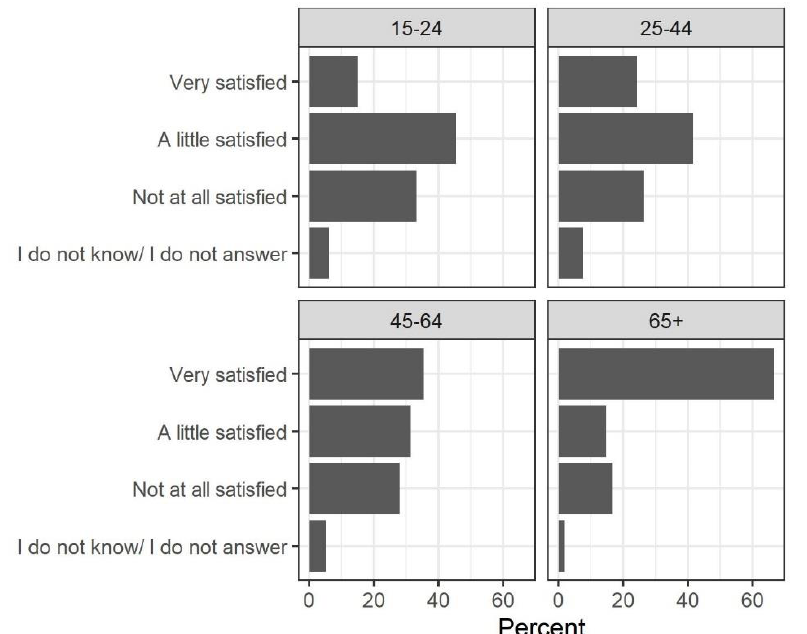
Figure A5. Cross-tabulation of attitudes of believers about the reaction of the Church by age (% by age). Χ 2 = 36.125, df = NA, p = 0.000 (Pearson’s Chi-squared test with simulated p -value based on 2000 replicates).